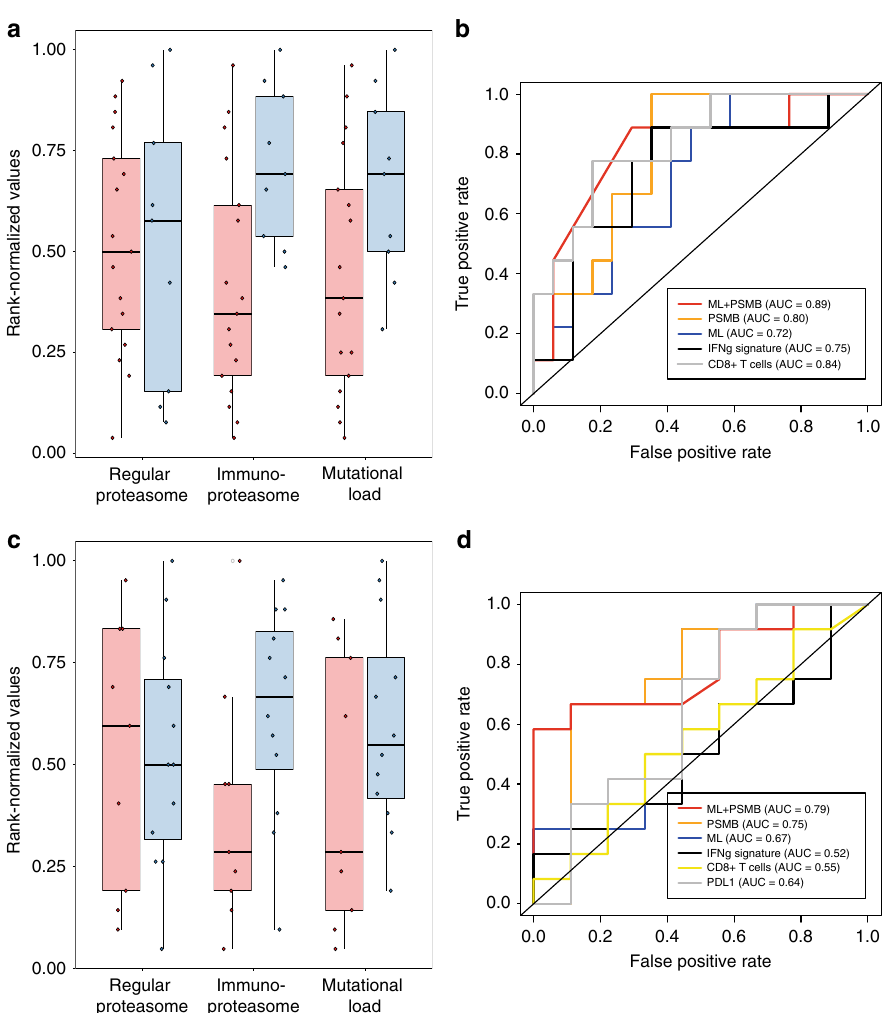
Fig. 5 IP expression is associated with better response to anti-CTLA4 and anti-PD1 therapy. a The responders to anti-CTLA4 therapy show signi fi cantly higher expression of IP subunits (one-sided Wilcoxon ranksum P < 0.006) and mutational load (one-sided Wilcoxon ranksum P < 0.03). No signi fi cant difference was observed in regular proteasome subunit expression ( PSMB5/6 ; Wilcoxon ranksum P > 0.5). b The IP subunits expression is predictive of the response to anti-CTLA4 therapy, quanti fi ed by area under the curve (AUC = 0.80, orange) of receiver operating curve (ROC), superior or comparable to the mutational load (AUC = 0.72, blue) and IFN γ signature (AUC = 0.75, black). In combination with ML, IP (PSMB) is the most predictive (AUC = 0.89, red) followed by CD8T (AUC = 0.87) and IFN γ (AUC = 0.84, black) or CD8T as a single variable (AUC = 0.82, gray). Precision-recall curve is shown in Supplementary Fig. 18a. c The responders to anti-PD1 therapy show signi fi cantly higher expression of IP subunits (one-sided Wilcoxon ranksum P < 0.03). No signi fi cant difference was observed in regular proteasome subunit expression ( PSMB5/6 ; one-sided Wilcoxon ranksum P > 0.5) and mutational load (one-sided Wilcoxon ranksum P > 0.1). d The IP (orange) is predictive of the response to anti-PD1 therapy (quanti fi ed by area under the curve (AUC = 0.75 of receiver operating curve (ROC)), superior to the mutational load (AUC = 0.67, blue), IFN γ signature (AUC = 0.52, black), CD8 + T-cell abundance (AUC = 0.55, yellow), and PDL1 expression (AUC = 0.64, gray). The combination of IP subunit expression and mutational load provides AUC = 0.79 (red). Precision-recall curve is shown in Supplementary Fig.